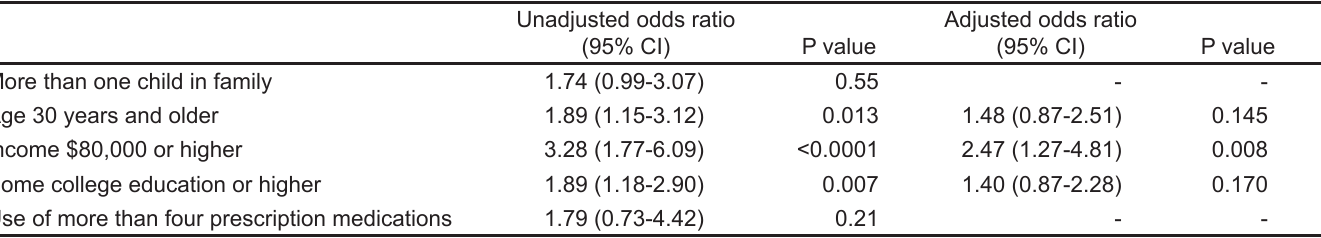
Table 5. Factors associated with placing prescription medications in a secure place (locked storage or above countertop). Multivariable analysis